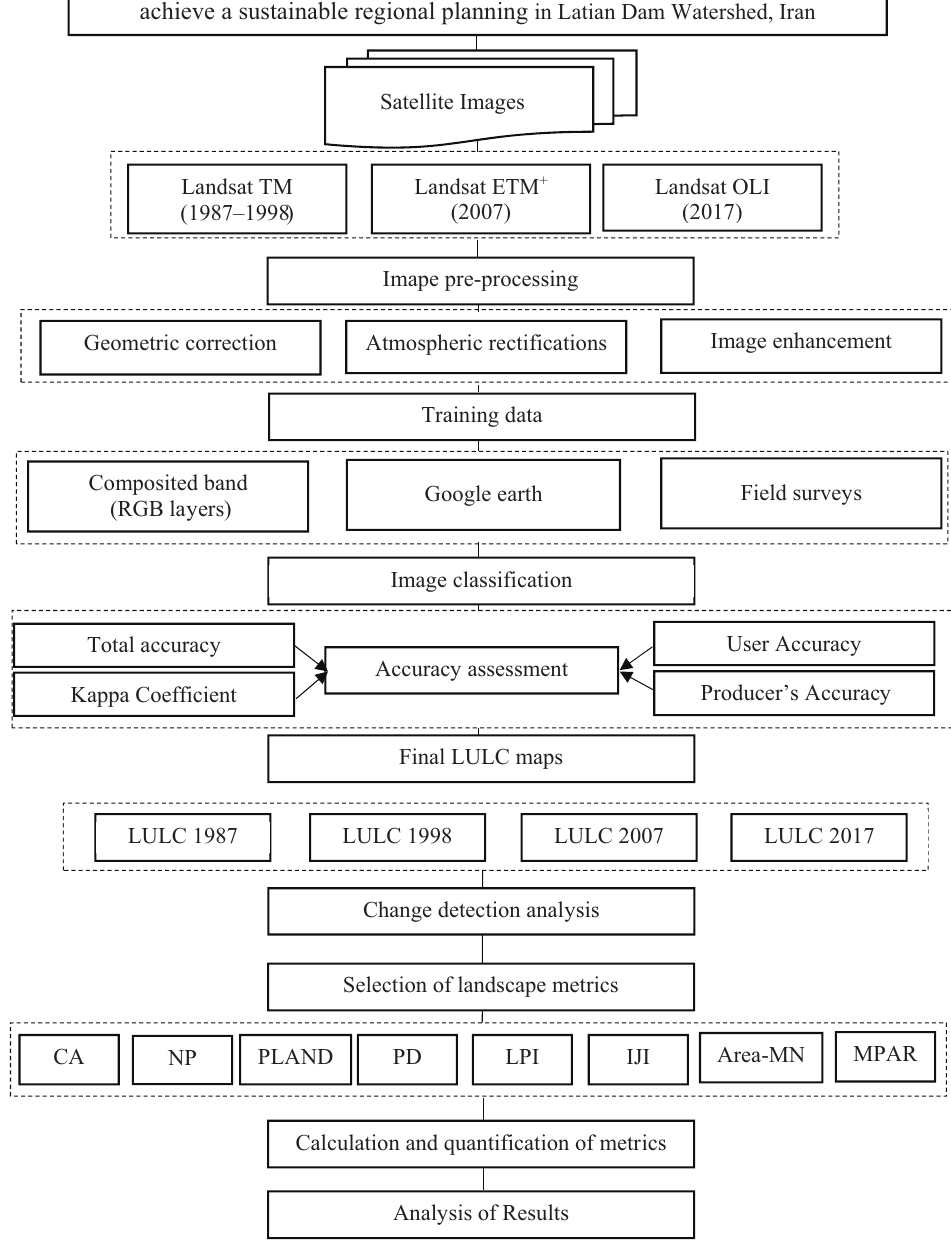
Figure 2. Methodology